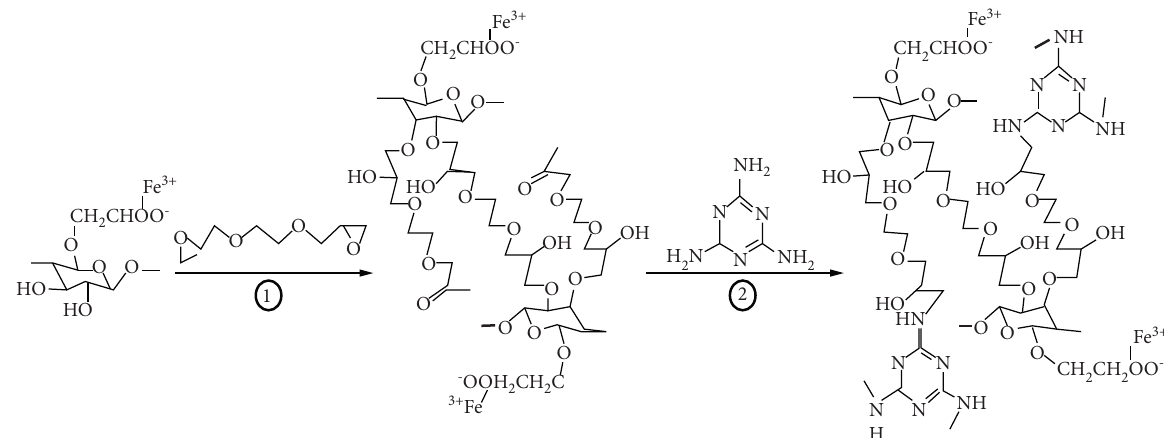
Figure 5: Schematic presentation of CMC cross-linked by EGDE (a) and ME (b).